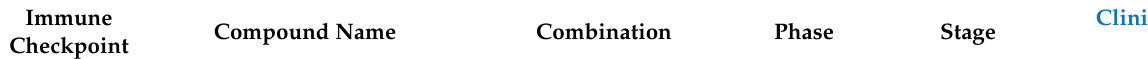
Table 1. Different compounds and their combinations in clinical trials. +/ − indicates a study performed with or without a specified compound, mAb: monoclonal antibody, IgG: immunoglobulin